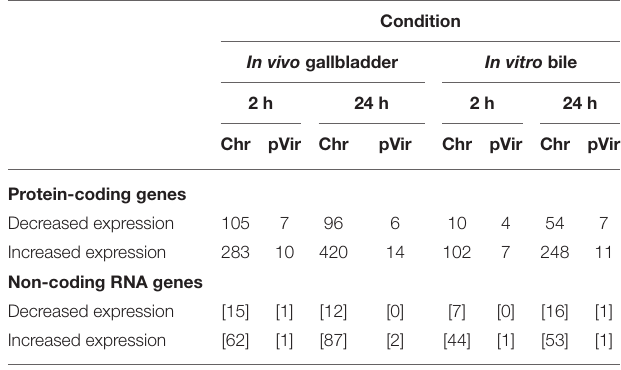
FIGURE 1 | Total CFU of C. jejuni IA3902 recovered following 2 and 24 h exposure to either the in vivo gallbladder environment or sheep bile only in vitro . Standard plate counts were used to determine the initial starting inoculum amount which averaged 10 11 total CFU for all in vivo and in vitro studies (indicated in the figure as a dashed red line). Standard plates counts were again used to determine the CFU/mL of viable C. jejuni following both in vivo and in vitro incubation for 2 or 24 h; this was then mutiplied by the total volume of bile collected to determine the total CFU of bacteria recovered. An average was then taken from the four replicates for each condition at each time point to demonstrate amount of starting material for RNA extraction under the different conditions.